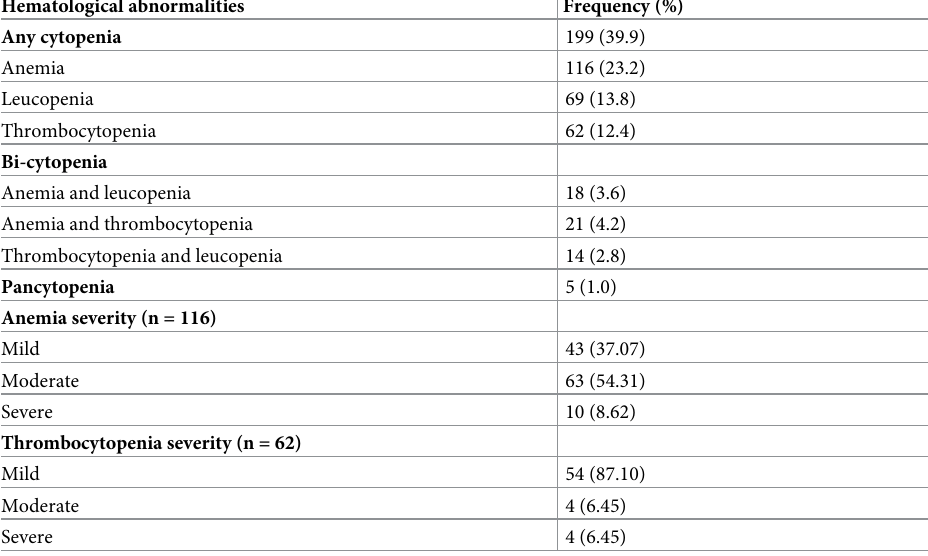
Table 3. Prevalence of cytopenias among HIV infected patients on HAART at Mahal-Meda Hospitals, Northern Shewa Zone, Ethiopia, 2018 (n = 499). Hematological abnormalities Frequency